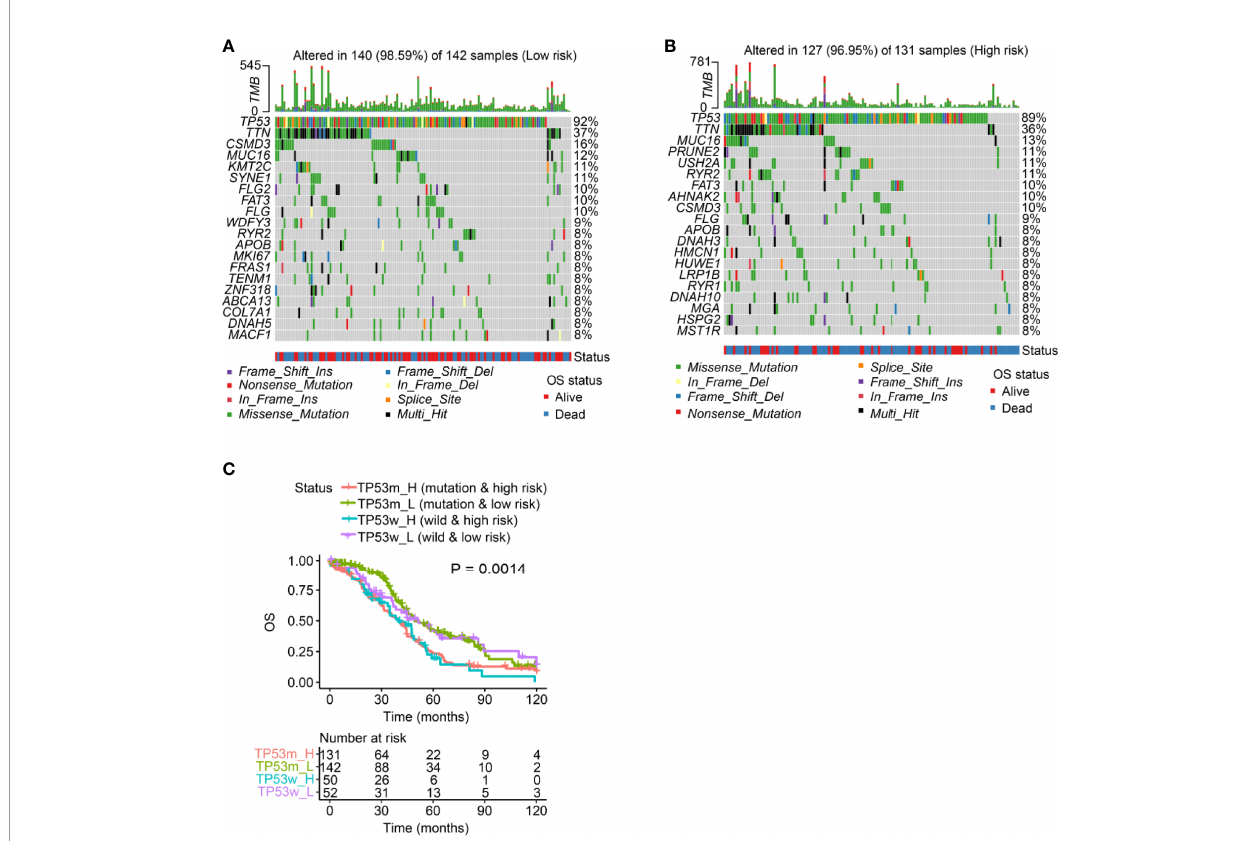
FIGURE 5 | Mutation analysis using the risk model in the entire set. (A, B) Waterfall plot displays mutation information of the genes with high mutation frequencies in the patients with low-risk scores (A) and those with high-risk scores (B) . (C) Overall survival analysis of patients classi fi ed according to the m 6 A/m 1 A/A-I/APA-LPR score and TP53 mutation status in the entire